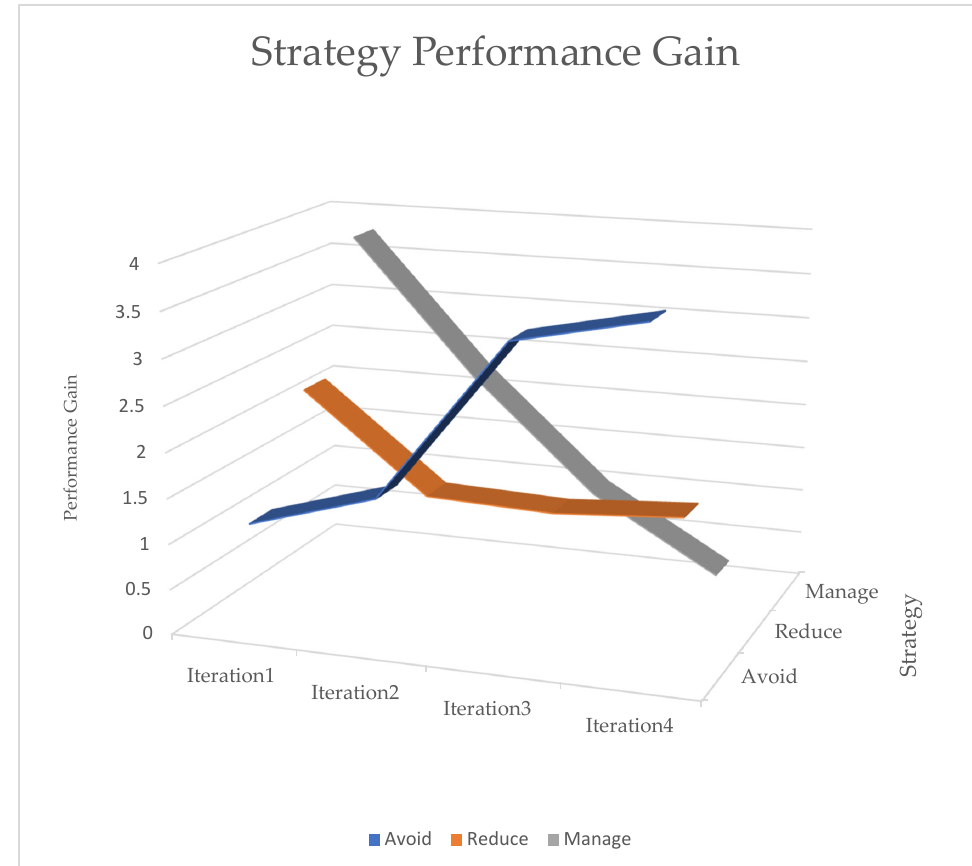
Figure 10. Combined analysis of the mitigation strategies of case studies 1 and 2.